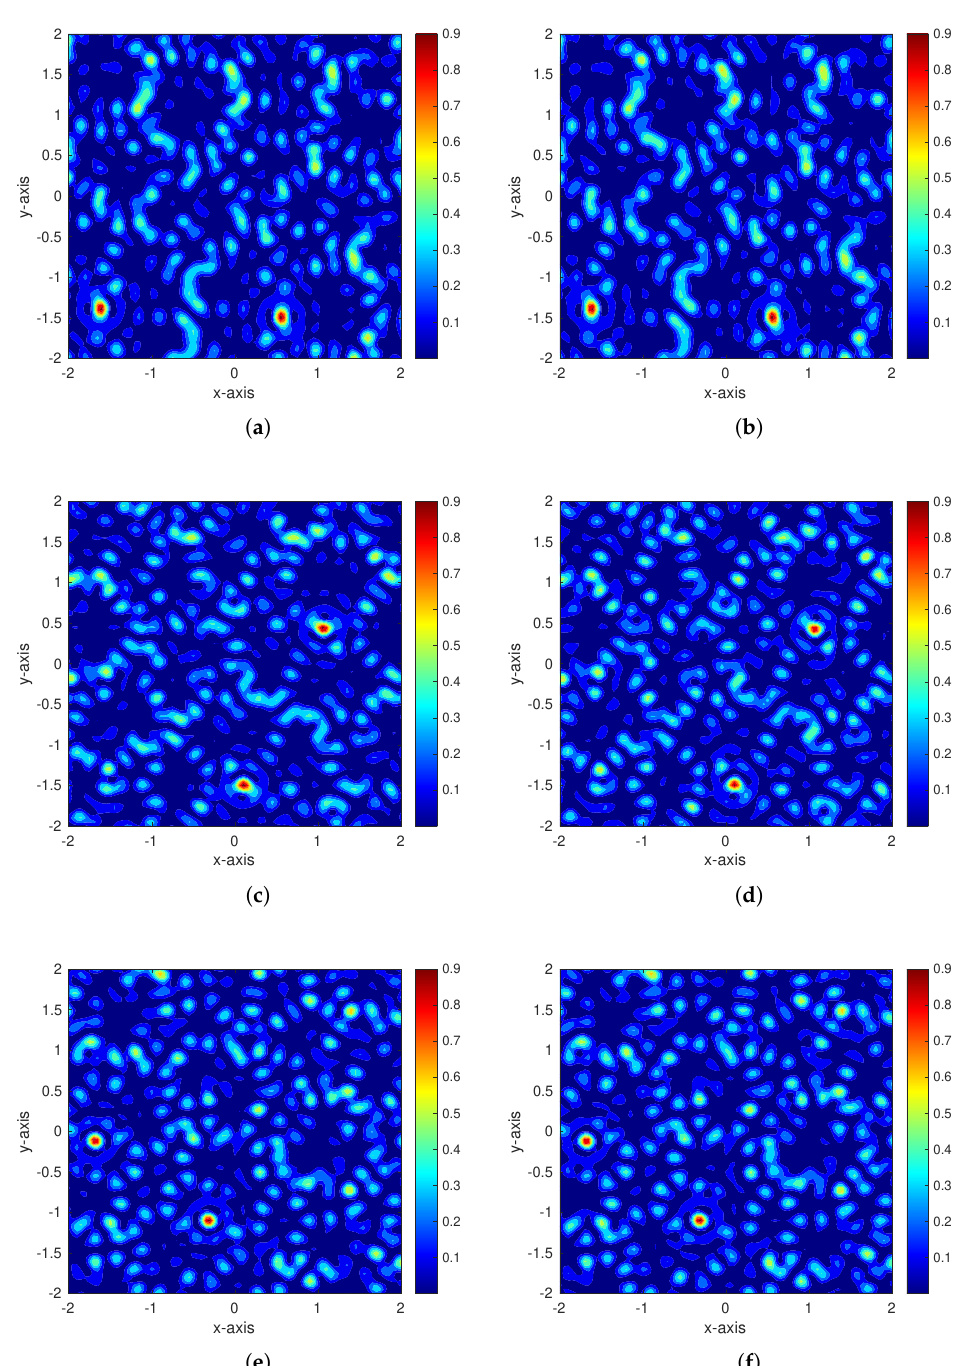
Figure 8. Imaging results for ground truth data and learning data with two scatterers. ( a ) true data No. 1; ( b ) learning data No. 1; ( c ) true data No. 400; ( d ) learning data No. 400; ( e ) true data No. 500; ( f ) learning data No.